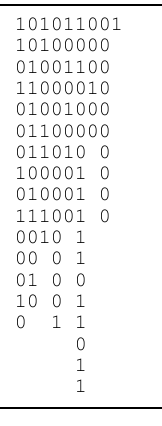
Table 1. Binary format for progressive sensor data